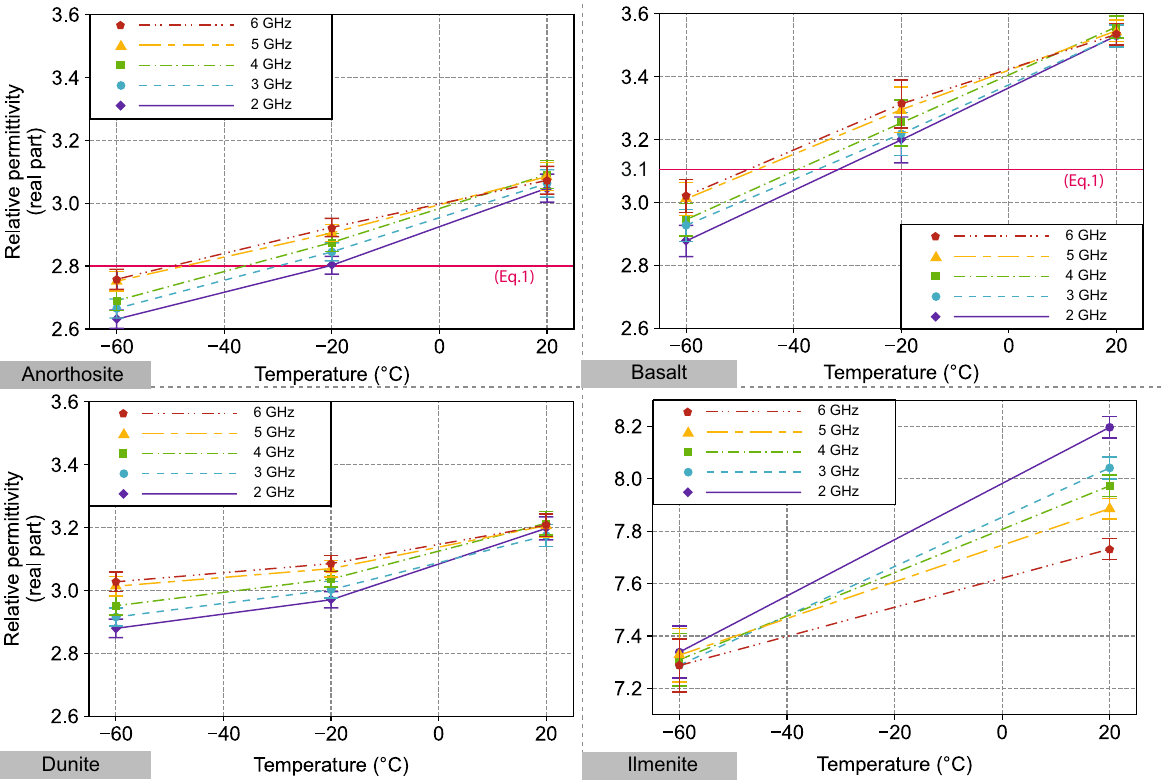
Fig. 1 Temperature dependence of the permittivity. a Anorthosite, b Basalt, c Dunite, and d Ilmenite. The circular points are the average of 10 points below and above each frequency (e.g., the average of the permittivity from 1.984–2.018 GHz in the case of 2 GHz). In the case of 6 GHz, it is averaged with the 10 points only below the frequency (i.e., the average of the permittivity from 5.966 to 6.000 GHz). The error bar shows the standard error. The colour shows the frequency (dark purple: 2 GHz, light blue: 3 GHz, green: 4 GHz, orange: 5 GHz, and dark red: 6 GHz), while the horizontal line shows the calculation result based on Eq. 1. in magenta, where appropriate. The calculation result is only shown in the case of the anorthosite and basalt, because Eq. 1 was derived from the Apollo sample and the dunite and ilmenite are minor components in the Apollo